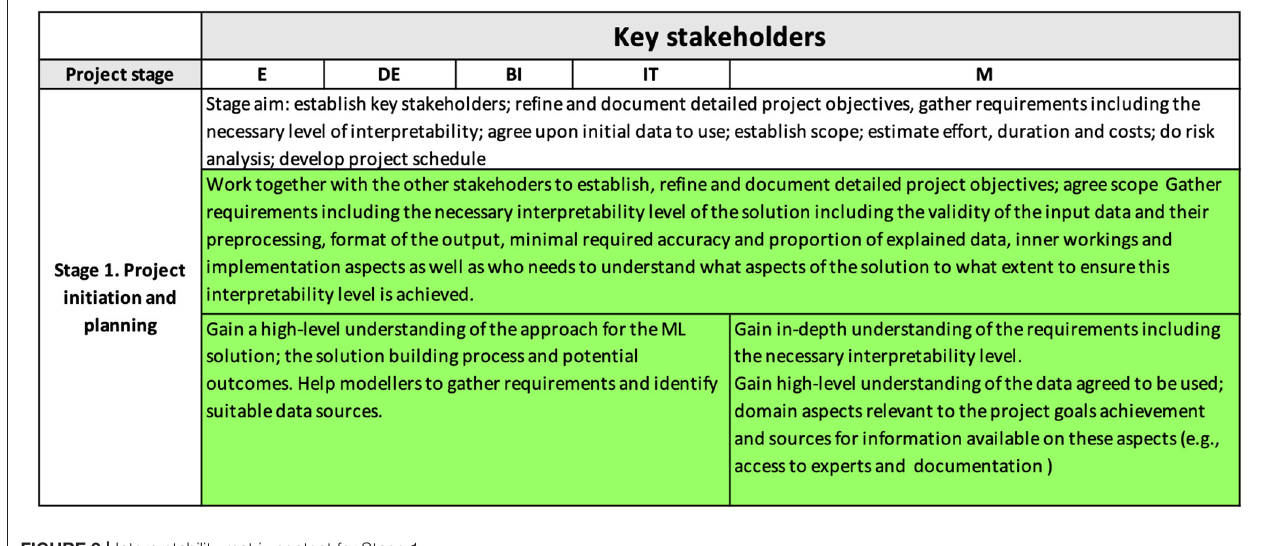
FIGURE 3 | Interpretability matrix content for Stage 1.